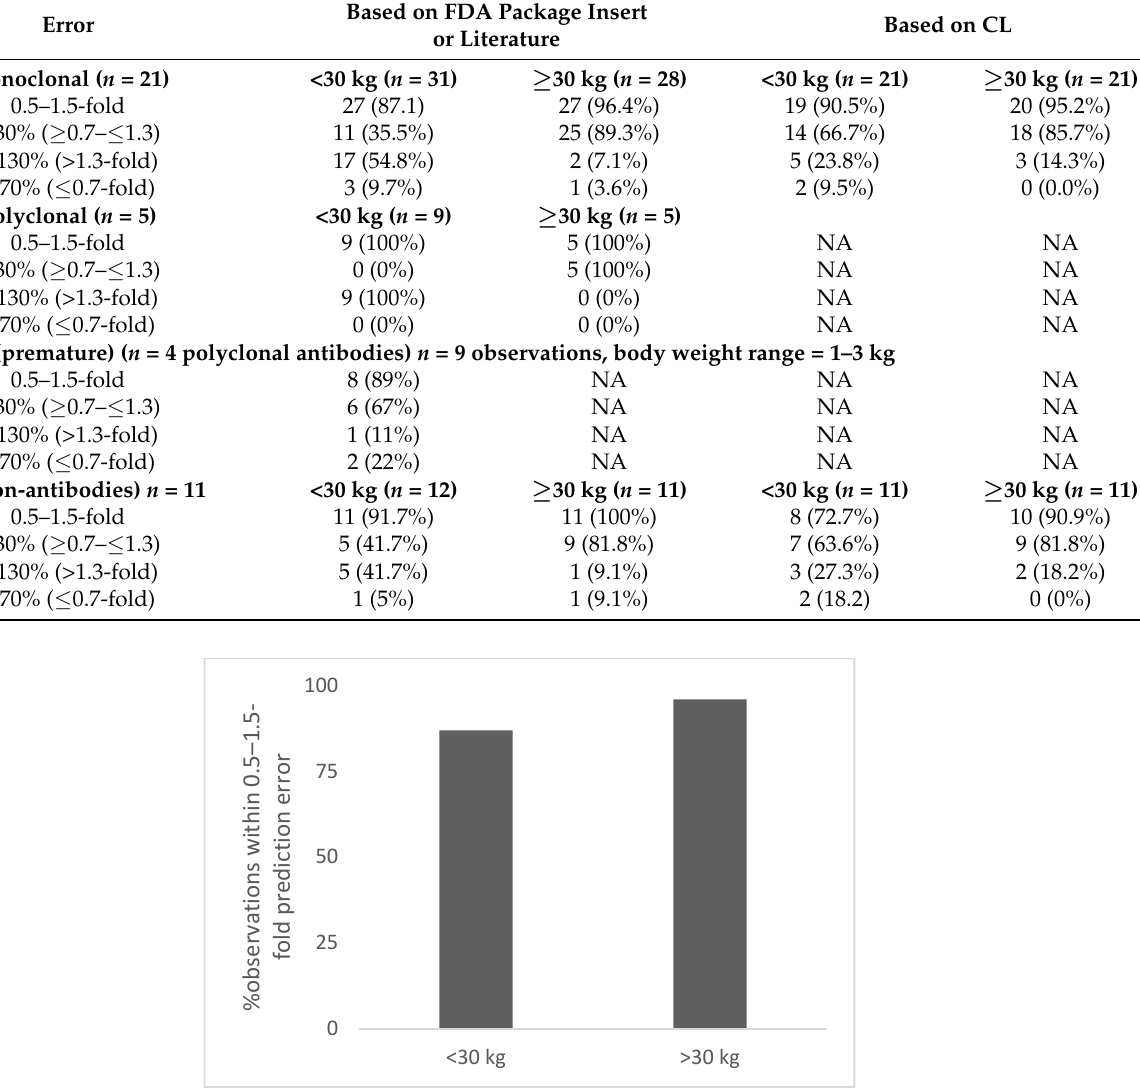
Figure 2. Percent observation within 0.5–1.5 ‐ fold prediction error for polyclonal antibodies (>2 years of age).